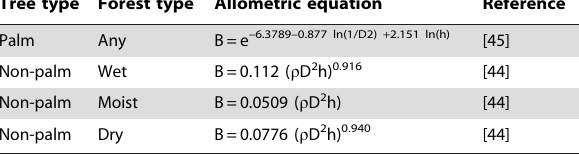
Tree type Forest type Allometric